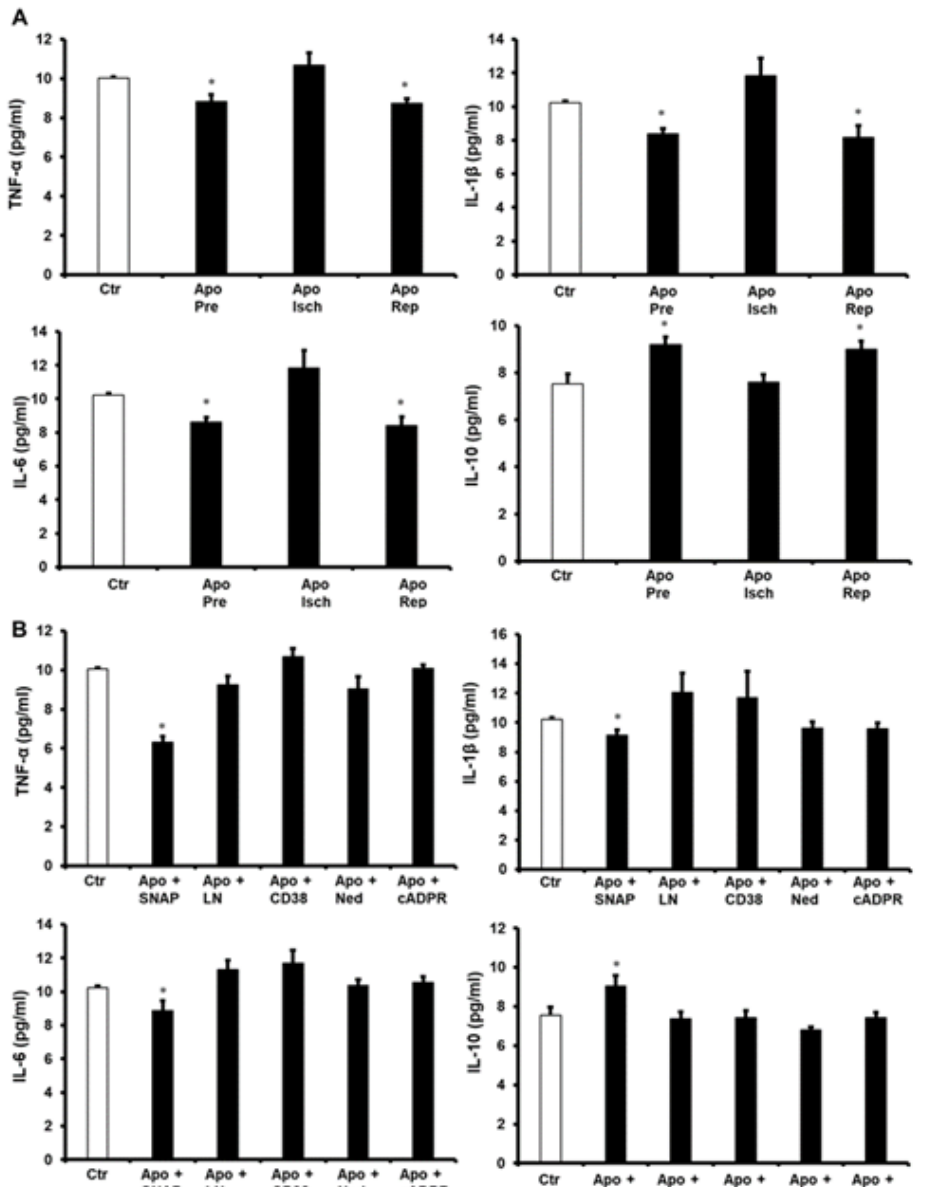
Figure 5. The levels of pro-inflammatory and anti-inflammatory cytokines in heart homogenates in all experiments. Quantification of TNF- α , IL-1 β , IL-6 and IL-10 in hearts treated with apocynin ( A ) or a combination of apocynin and SNAP, L-NAME, 78c, Ned, or cADPR agonist ( B ) (n = 4 per group). Data are shown as means ± SEM. Ctr, control; Apo, apocynin; Pre, before ischemia, Isch, during ischemia; Rep, at reperfusion; SNAP, nitric oxide donor, LN, L-NAME; 78c, CD38 blocker; Ned, NAADP inhibitor; cADPR, cADPR agonist. * p < 0.05 compared to